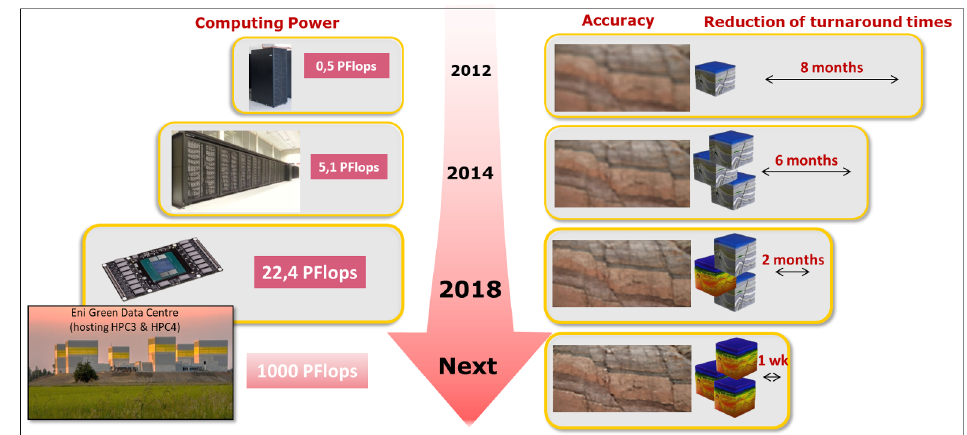
Fig. 4. – Digital simplification of